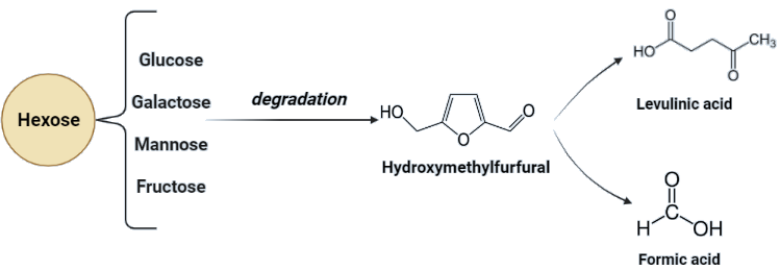
Figure 3. Chemical structures of inhibitory compounds are generated due to secondary transforma- tions of hexoses during acidic pre-treatment